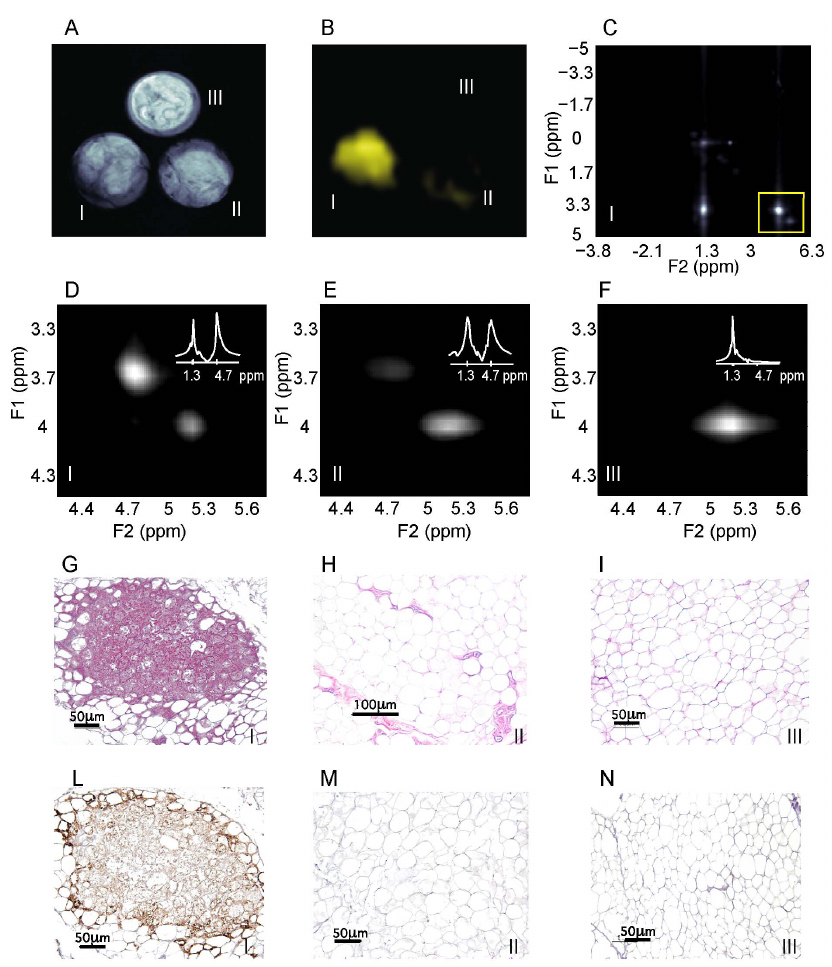
Figure 7. In vitro detection of human BAT using the BATSCI signal. ( A ) Spin echo image of 3 human BAT samples: supraclavicular fat from a 27 year old male (I, bottom left), supraclavicular fat from a 95 year old female (II, bottom right) and abdominal fat from the same 95 year old female (III, top) ( B ) BATSCI map obtained from the same 3 samples. Only the fat sample excised from the supraclavicular area of the 27 years old male (bottom left) shows a significant BATSCI signal. ( C ) 2D iZQC spectrum acquired on the 27 year old male supraclavicular fat sample highlighting (yellow box) the region containing the water-fat and the fat-fat iZQC peak. ( D ) 2D-iZQC spectrum showing the water-fat (BATSCI) and the fat-fat iZQC peak from the supraclavicular fat sample of the 27 year old male, along with the 1 H-MRS spectrum (inset). ( E ) 2D-iZQC spectrum from the supraclavicular fat of the 95 year old female showing a predominant fat-fat iZQC peak, along with the 1 H-MRS spectrum (inset). ( F ) iZQC spectrum from the abdominal area of the 25 year old female showing only a fat-fat iZQC peak, along with the 1 H-MRS spectrum (inset). ( G–I ) Histological haematoxylin and eosin (H&E) staining of BAT from the 27 year old supraclavicular fat ( G ), the 95 year old supraclavicular fat ( H ) and 95 year old abdominal fat ( I ). ( L–N ) immunohistochemistry of the same samples to detect UCP1